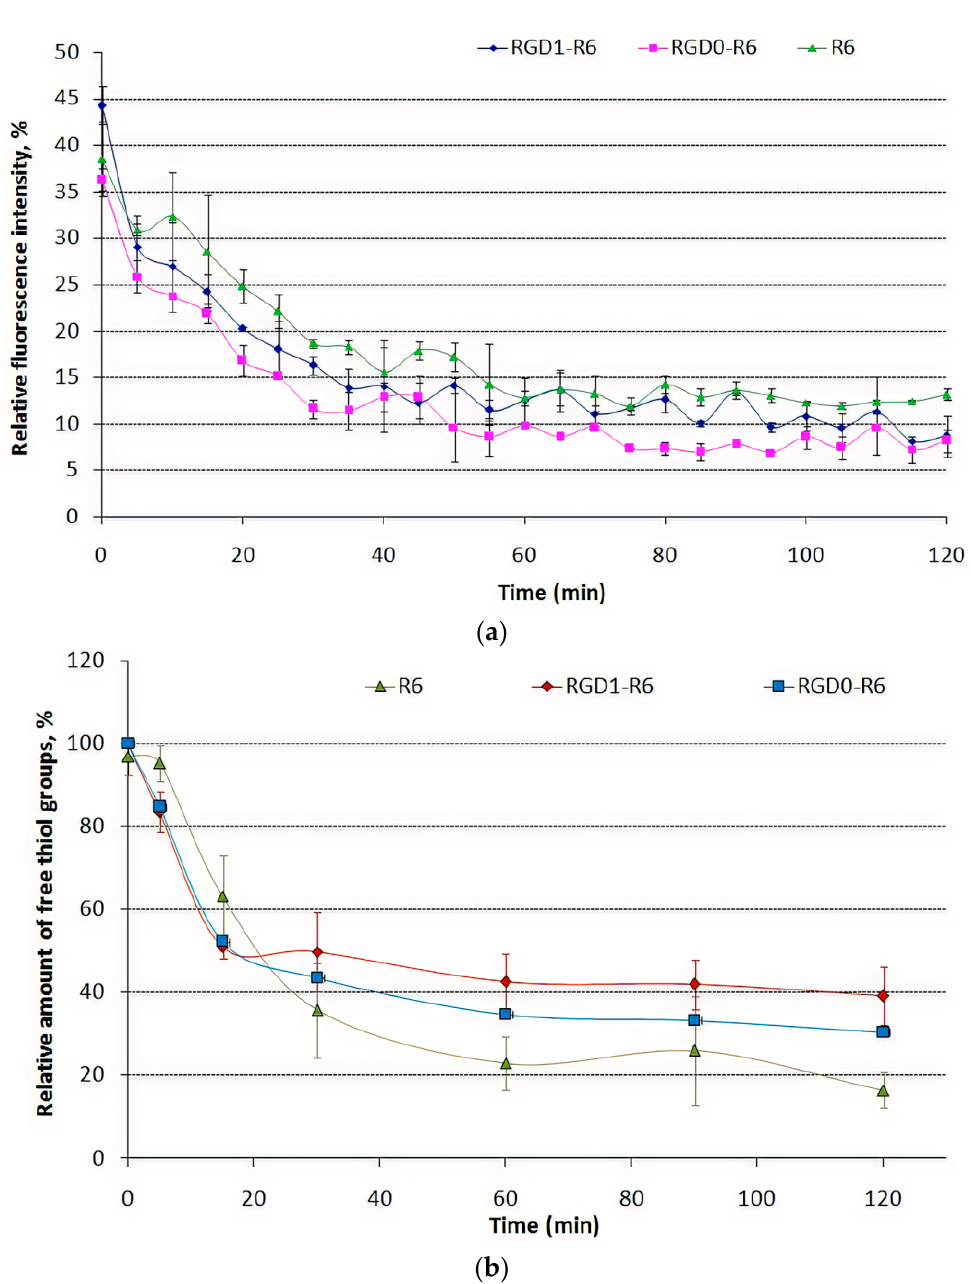
Figure 3. Monitoring of the polyplexes formation: ( a ) by SYBR Green exclusion assay and ( b ) by Ellman’s assay to measure of relative amount offree thiol groups inRGD1-R6/DNA, RGD0-R6/DNA and R6/DNA complexes. Values are the mean ± SD of the mean of triplicates.